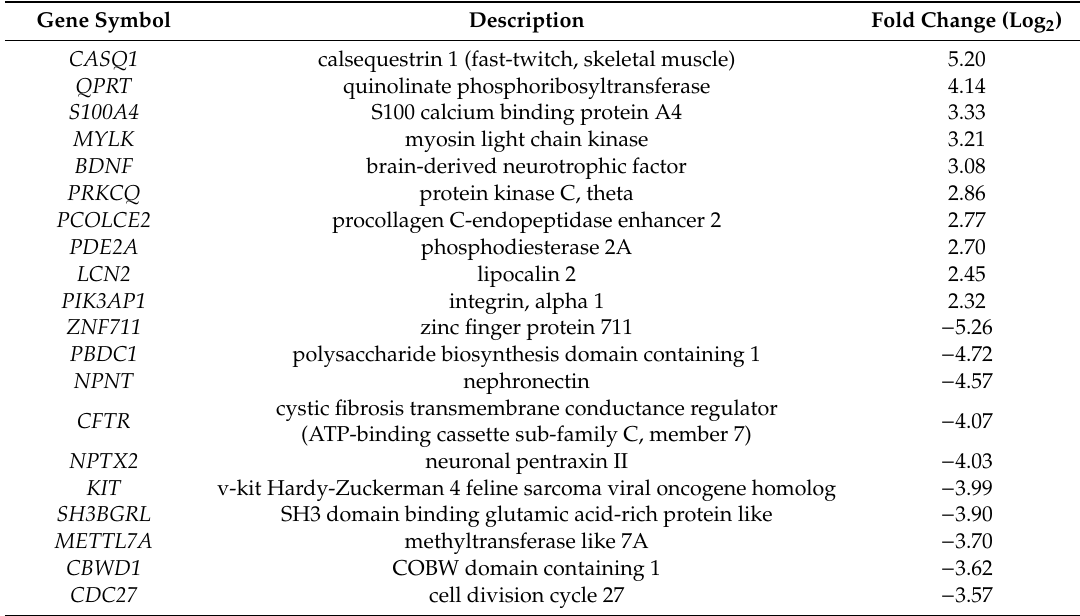
Table 1. Top 10 up- and down-regulated genes in high mobility group adenine–thymine (AT)-hook 2 (HMGA2)-overexpressing DLD-1 cells.